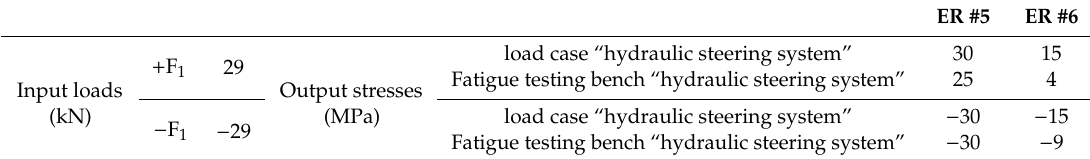
Table 6. Stress calculated on the basis of MSC / AdamsCar and measured based on the hydraulic steering system